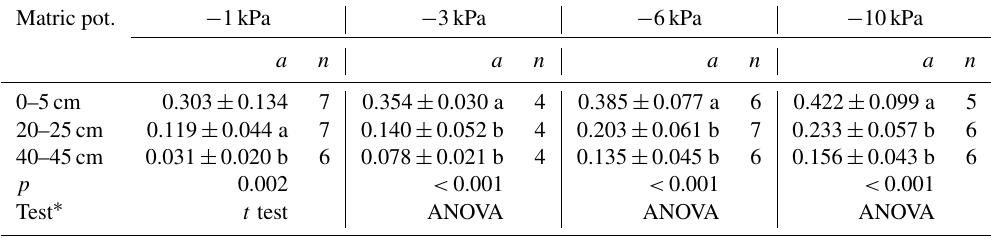
Table 1. Means and standard deviations for the measured air-filled porosity ( a , m m − 3 ) of the peat samples at different matric potentials. Matric pot. − 1kPa − 3kPa − 6kPa − 10kPa a n a n a n a n 0–5cm 0.303 ± 0.134 7 0.354 ± 0.030 a 4 0.385 ± 0.077 a 20–25cm p 0.002 < 0.001 < 0.001 < 0.001 Test ∗ t test ANOVA ANOVA